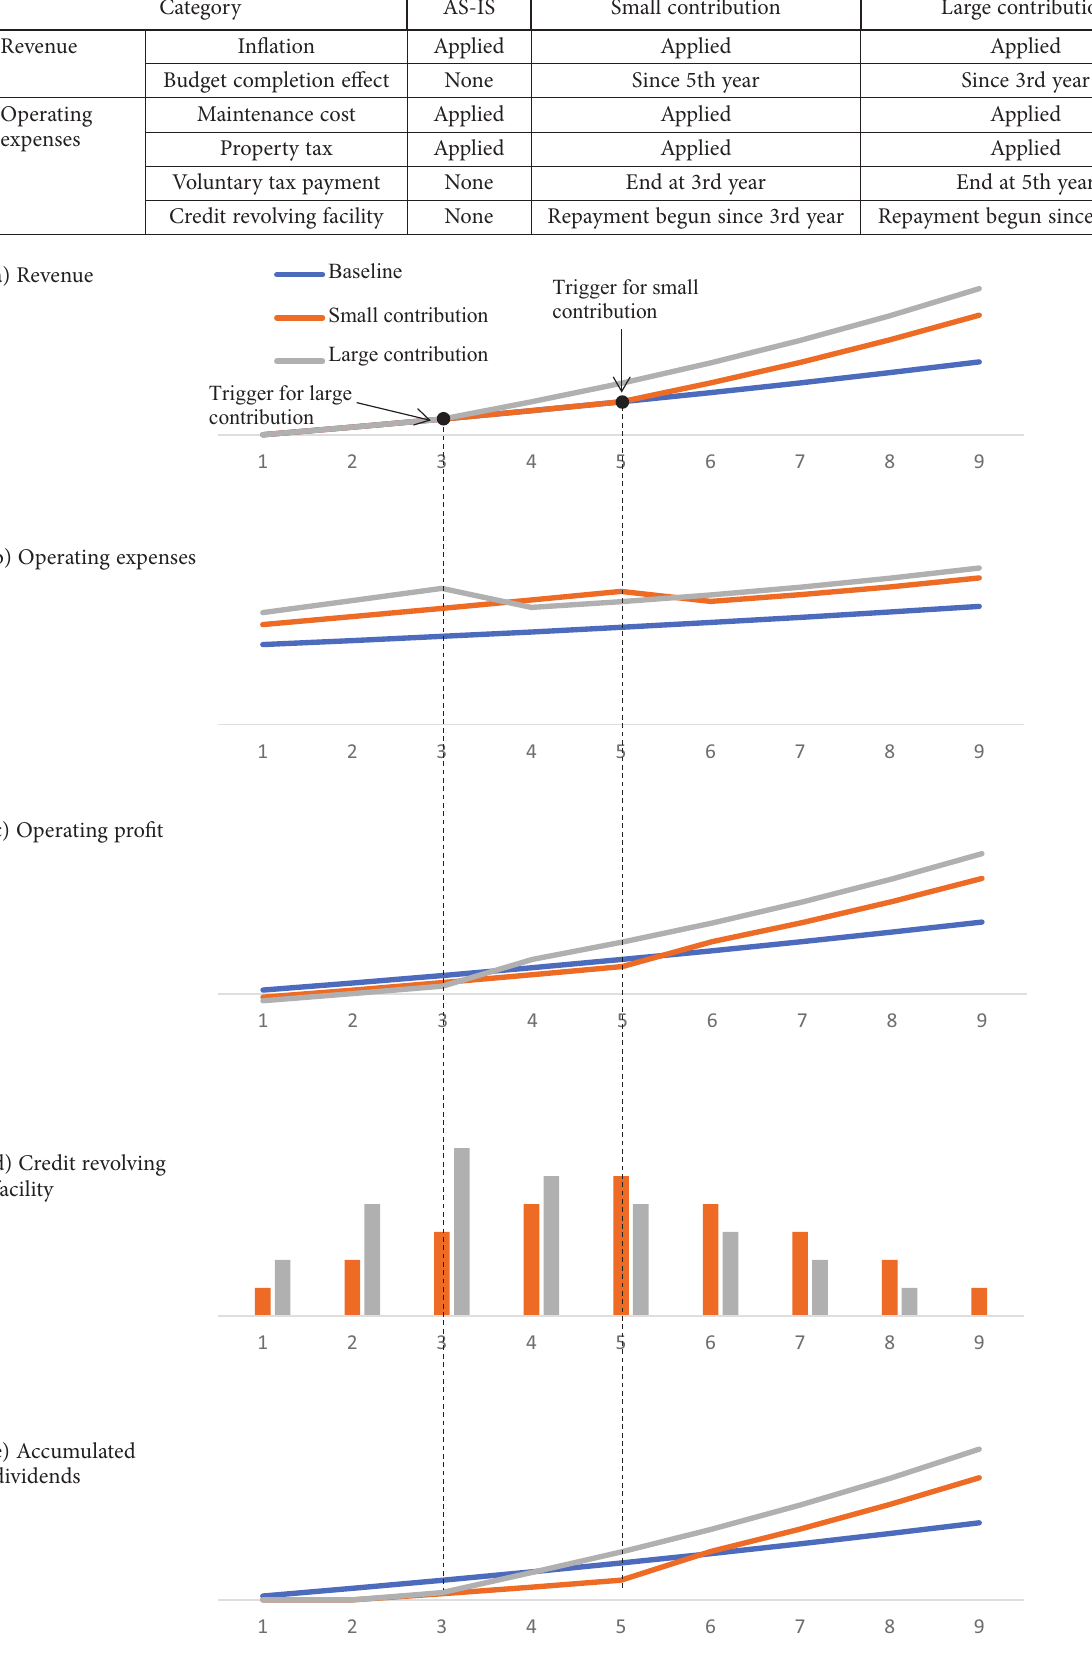
Figure 3. Key variables and their reference modes (Y axis: monetary value; X axis: time)